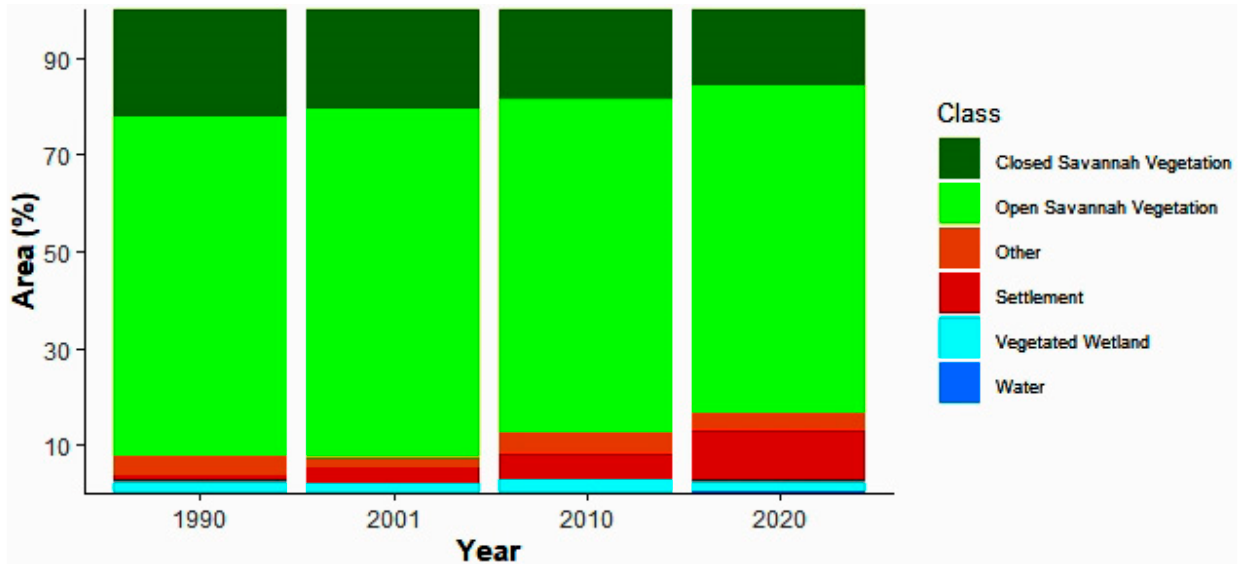
Figure 3. Land use and land cover map for Wa Municipality for the year 1990, 2001, 2010 and 2020.